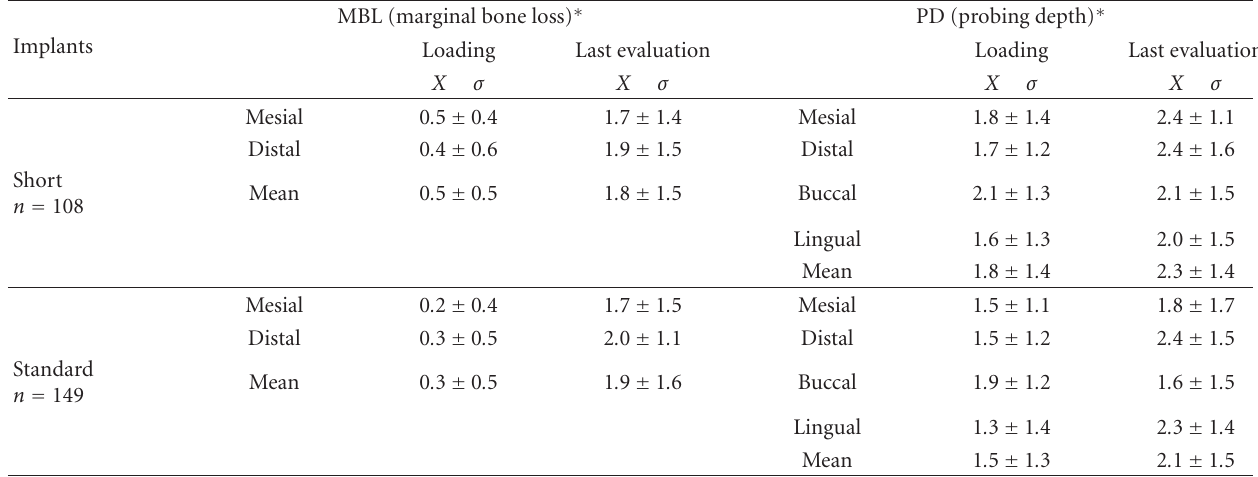
Table 5: Radiographic and clinical assessments at time of prosthetic loading and at last evaluation.